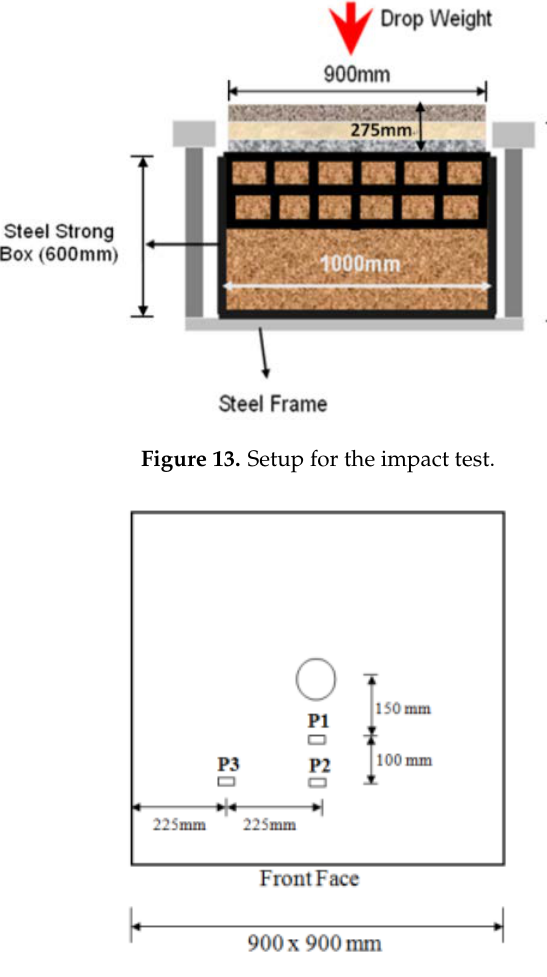
Figure 14. Positioning of the potentiometers.